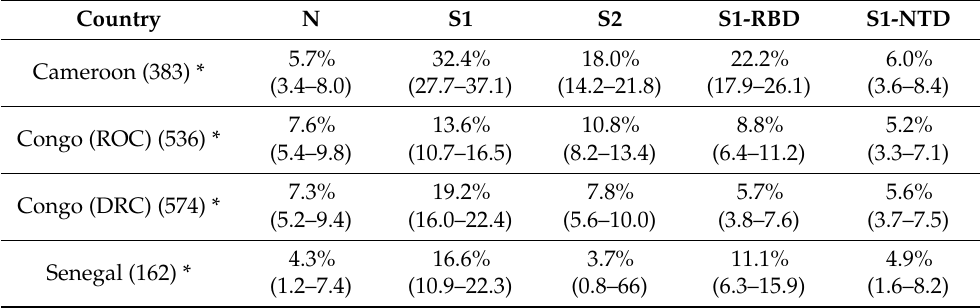
Table 3. Number of samples with values above the threshold, by country. For each antigen and each country, the table indicates the percentage and 95% confidence interval of samples with value above the